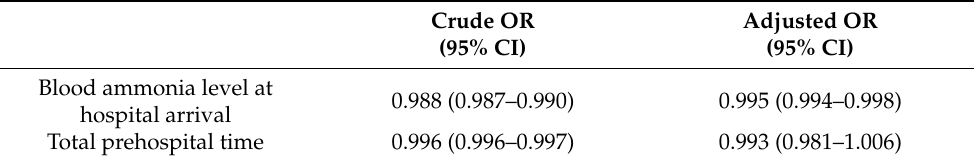
Table 2. Univariable and multivariable logistic regression analysis of blood ammonia level and total prehospital time for favorable neurological outcomes.